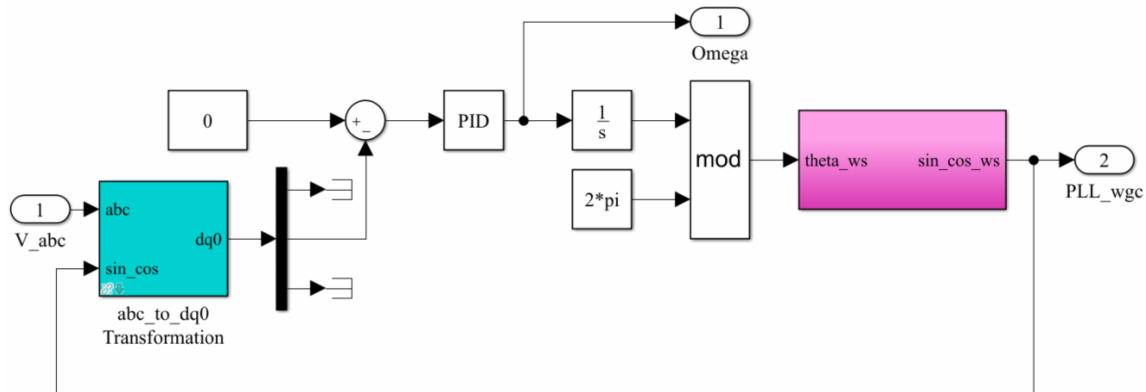
Figure 9. Simulation model of phase locked loop.